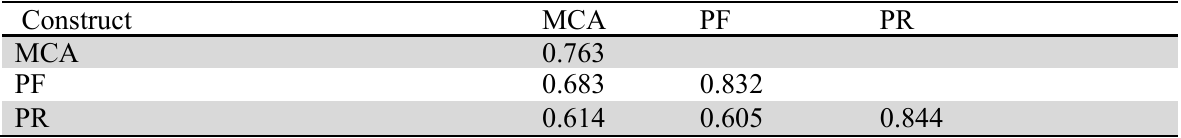
Discriminant validity (Fornell-Larcker) Construct